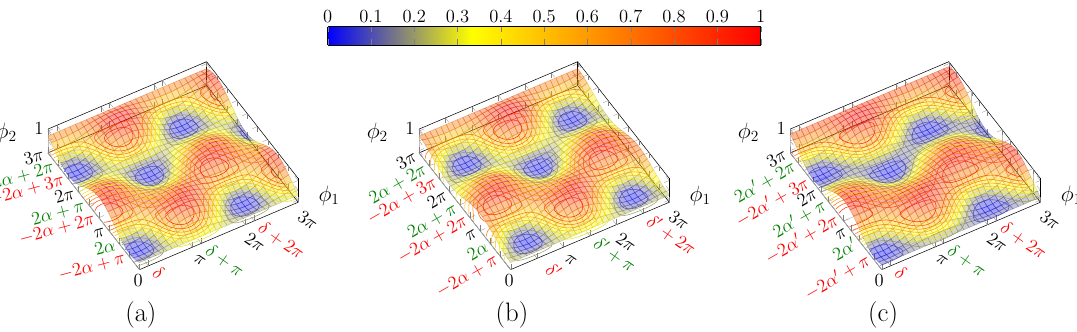
Figure 5. Plot of P L ( φ 1 , φ 2 ) for: ( a ) α = π /3 and δ = π /6; ( b ) same α but δ = π /2, where the surface is shifted along φ 1 , but retains the same shape as ( a ); and ( c ) α = 3/8 π but same δ as in ( a ). Note that the surface has a different shape with respect to ( a ), even though the extrema lie in the same φ 1 values. Red and green ticks correspond to the first and second solution classes,